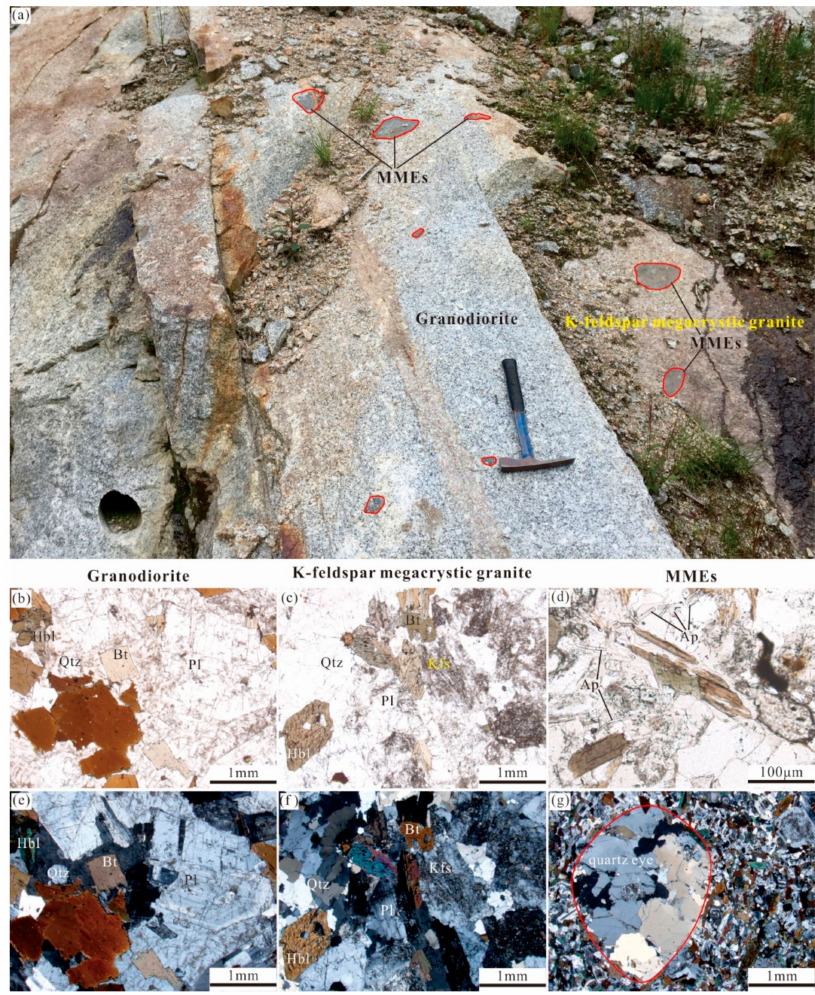
Figure 2. Photographs of an outcrop and photomicrographs of the host granodiorite and mafic microgranular enclaves (MMEs) in the Daocheng batholith. ( a ) wild outcrop of MMEs, ( b ) single polarized photo of granodiorite, ( c ) single polarized photo of K-feldspar megacrystic granite, ( d ) single polarized photo of MMEs, ( e ) orthogonal polarized photo of granodiorite, ( f ) orthogonal polarized photo of K-feldspar megacrystic granite and ( g ) quartz eyes. Mineral abbreviations: Bt = biotite, Hbl = hornblende, Pl = plagioclase, Kfs = K-feldspar, Qtz = quartz, Ap =